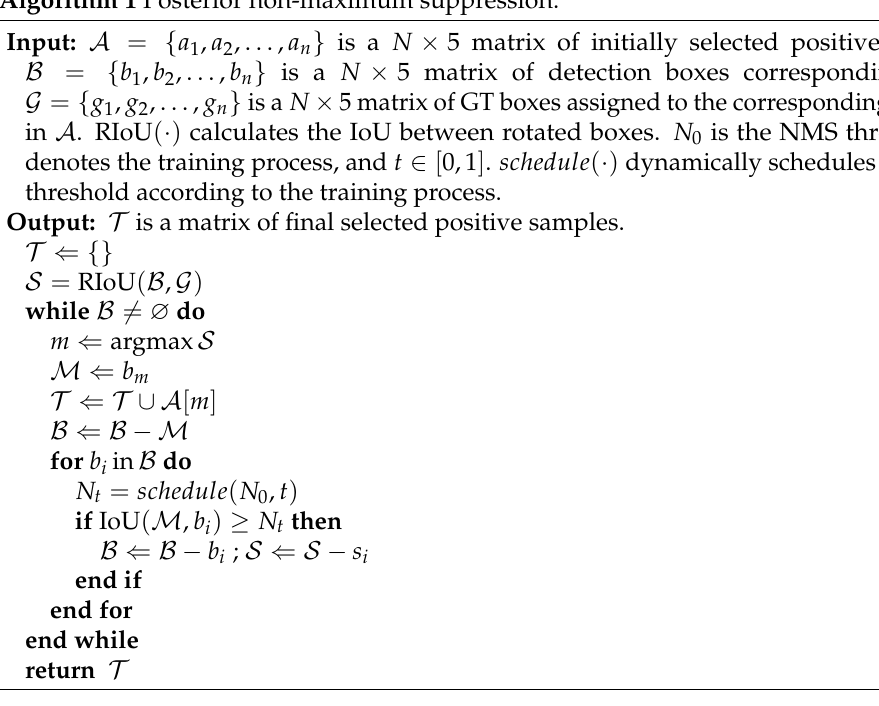
Figure 3. Display of the different label assignment strategy, including ( a ) dense label assignment (DLA) and ( b ) sparse label assignment (SLA). SLA alleviates the false detections caused by misaligned classification and regression by performing posterior NMS on the posterior predictions. Algorithm 1 Posterior non-maximum